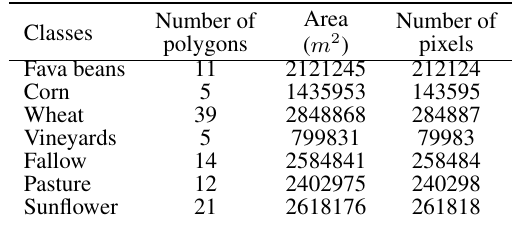
Figure 1. Regions of interest selected during the 2019 in situ measurement campaigns. Map data c (cid:13) 2015 Google The most represented classes of vegetation described during the campaigns are listed below and were used for the classifications as shown in Table 1.